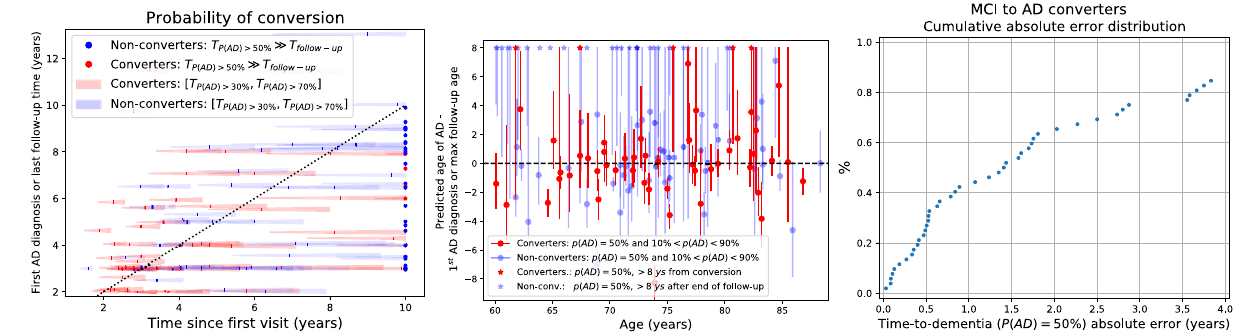
Figure 6. Predicted time to AD conversion for subjects enrolled with an MCI diagnosis who do not convert to AD during the first 2 years of follow-up. Left: Time from the first visit to the first AD diagnosis (for converters, in red) or maximum follow-up time (for non-converters, in blue) is shown in the y -axis. Shaded regions show the time when the predicted probability of AD is larger than 30% (left end) up to 70% (right end), with a mark denoting the time corresponding with a 50% AD probability. The dots on the right of the figure represent subjects whose predicted time of conversion is larger than 10 years. Centre: In red it is shown the time to conversion error (predicted minus actual time of conversion) vs age for converters. In blue is shown the difference between the predicted age of conversion minus the maximum follow-up time for non-converters. Right: Cumulative absolute error distribution for